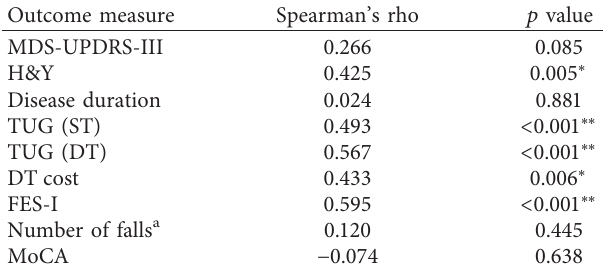
Table 4: Correlations of NFOG-Q with other outcome measures only for subjects without major cognitive impairment ( n � 45). Outcome